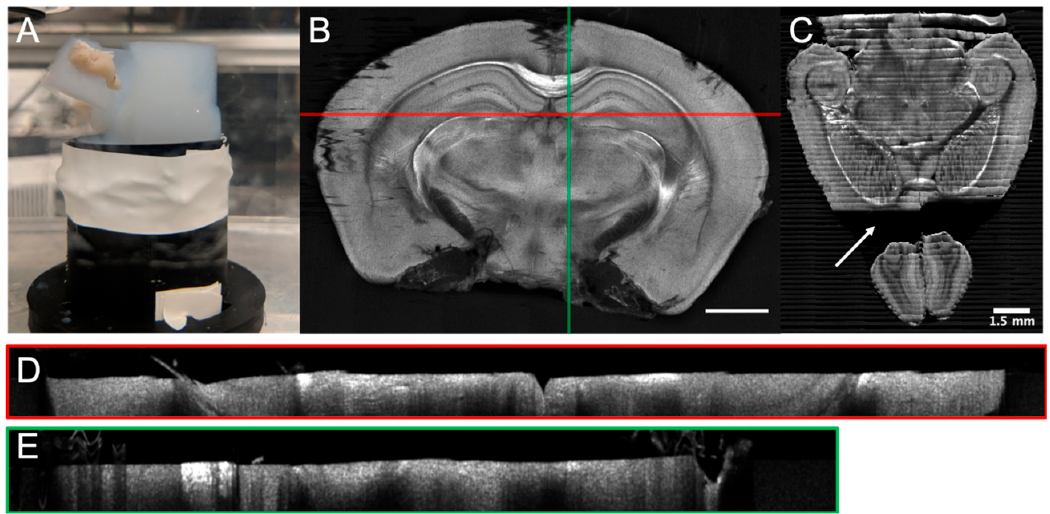
Figure 4. Examples of tissue sectioning artefacts for a serial OCT mouse brain: ( A ) Agarose tearing, ( B ) coronal slice exhibiting shadowing effects due to floating fibers, ( C ) horizontal slice with missing tissue due to tissue/agarose separation (arrow), ( D ) B-Scan corresponding to the horizontal red line of image B showing water-tissue interface denivelation, and ( E ) B-Scan corresponding to the vertical green line in Figure 4B, showing floating tissue fibers and their shadow. The scale bar is 1.5 mm.